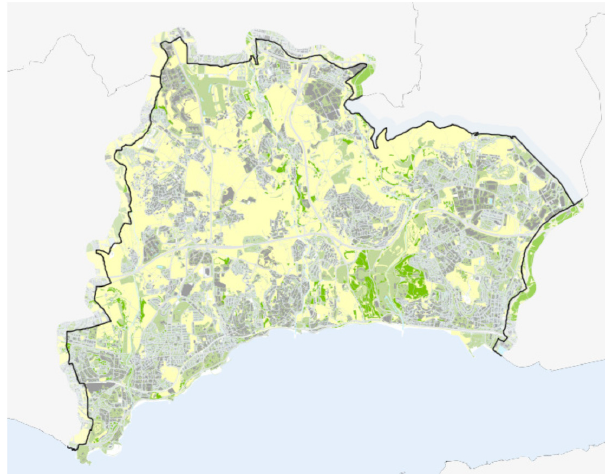
Figure 3. Cartography.